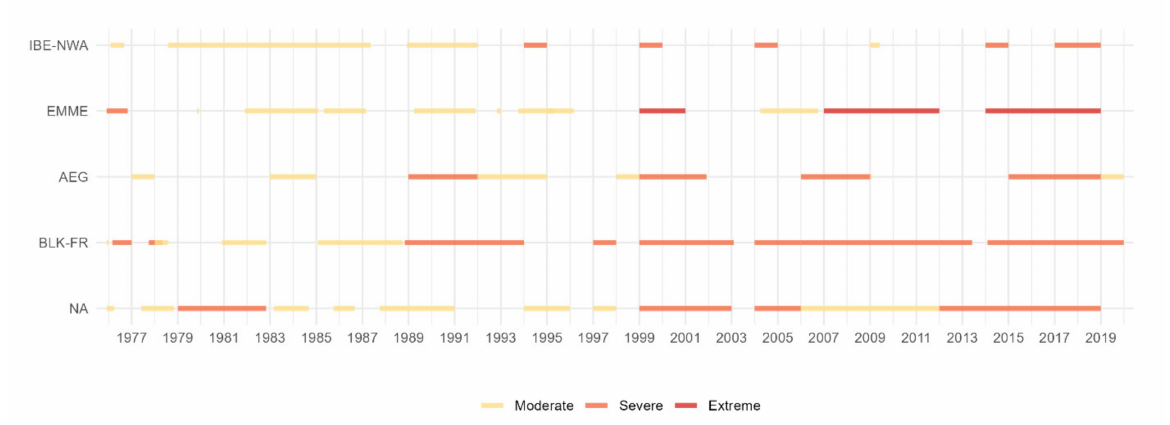
Figure 3. Subregional drought events in 1975–2019 identified by the